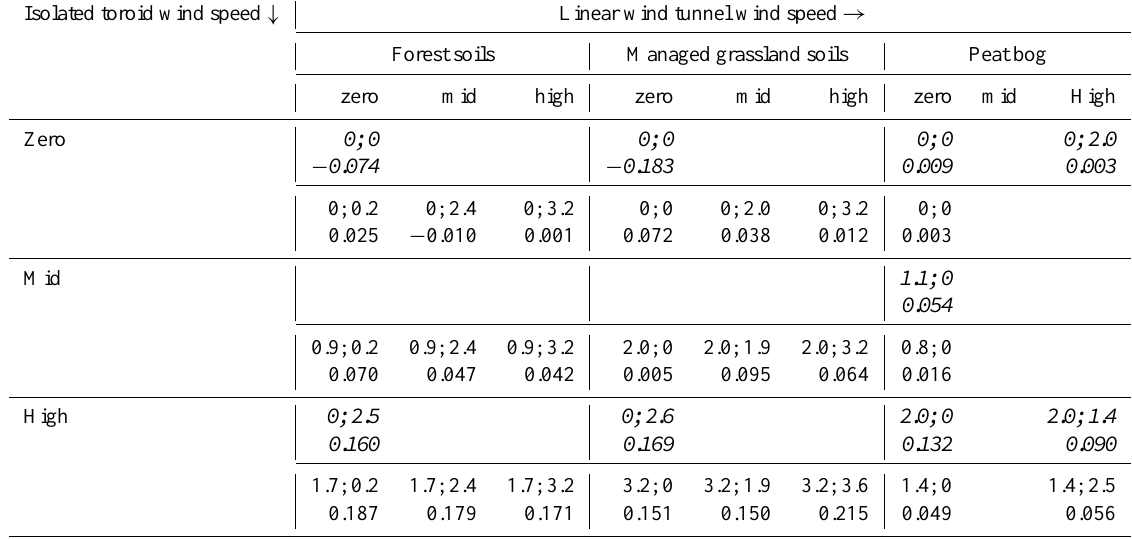
Table 1. Average chamber wind speed and pressure differential for various inner toroid–outer wind tunnel treatments. Italicized top values are for data collected in April 2011 (grassland and forest) and September 2011 (peat bog) while non-italicized bottom values indicate data collected in December and August 2011 and September 2012 for forest, grassland, and peat bog respectively. Upper values are wind speeds (inner toroid; outer wind tunnel) and are listed in ms − 1 . No standard deviations are listed since wind speeds were consistent to ± 0.1ms − 1 at each emplacement. Pressure differential (defined as outer wind tunnel pressure minus inner toroid pressure) is listed below wind speeds and is shown in